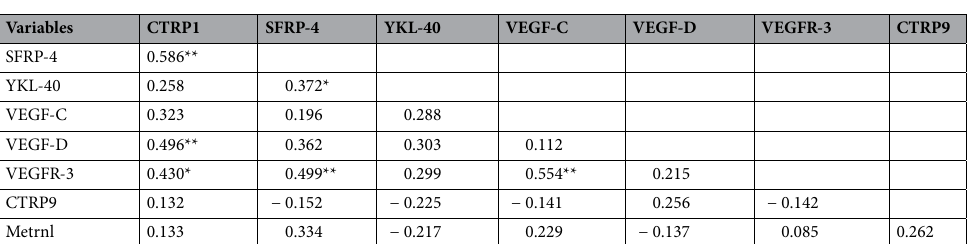
Table 6. The correlation matrix of cytoadipokines mRNA expression in PAT. CTRP, complement-Clq TNF- related protein; SFRP4, secreted frizzled-related protein 4; YKL-40, Chitinase-3-like protein 1; VEGF, vascular endothelial growth factor; VEGFR-3, vascular endothelial growth factor receptor 3; Metrnl, Meteorin-like. *P < 0.05, **P < 0.01.